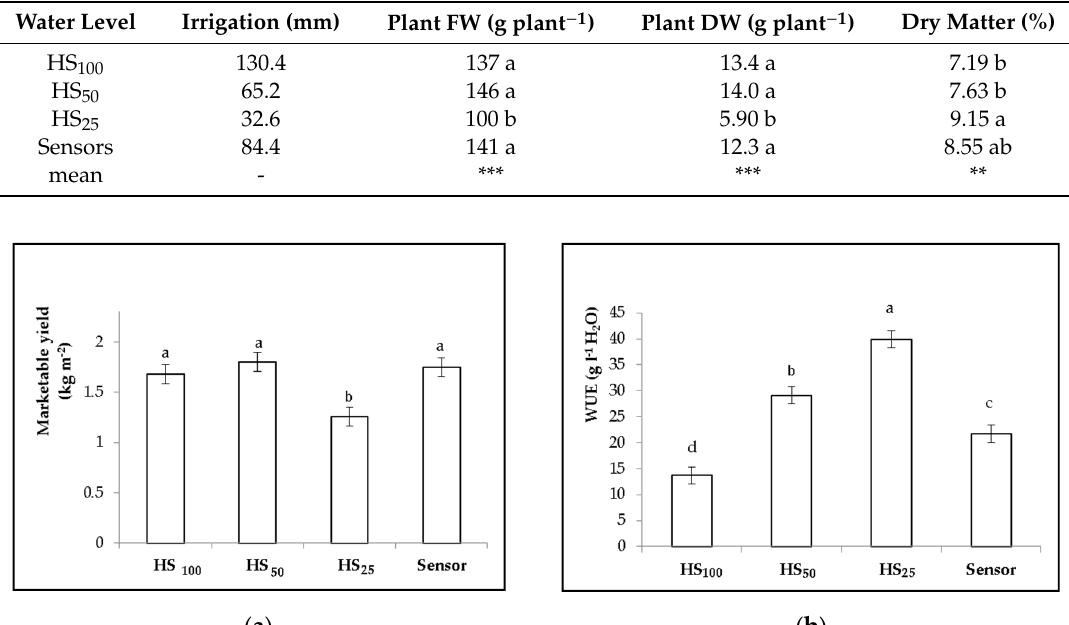
Figure 1. Effect of the irrigation strategy (HS 100 = recovery of 100% ET c calculated by the Hargraves–Samani equation; HS 50 = recovery of 50% ET c calculated by the Hargraves–Samani equation; HS 25 = recovery of 25% ET c calculated by the Hargraves–Samani equation; Sensors = recovery of irrigation through soil moisture sensors) on lettuce ( a ) Marketable yield, (kg FW m − 2 ) and ( b ) water use efficiency, (WUE, g FW L − 1 H 2 O). Vertical bars indicate SE, different letters indicate significant differences with p ≤ 0.05.